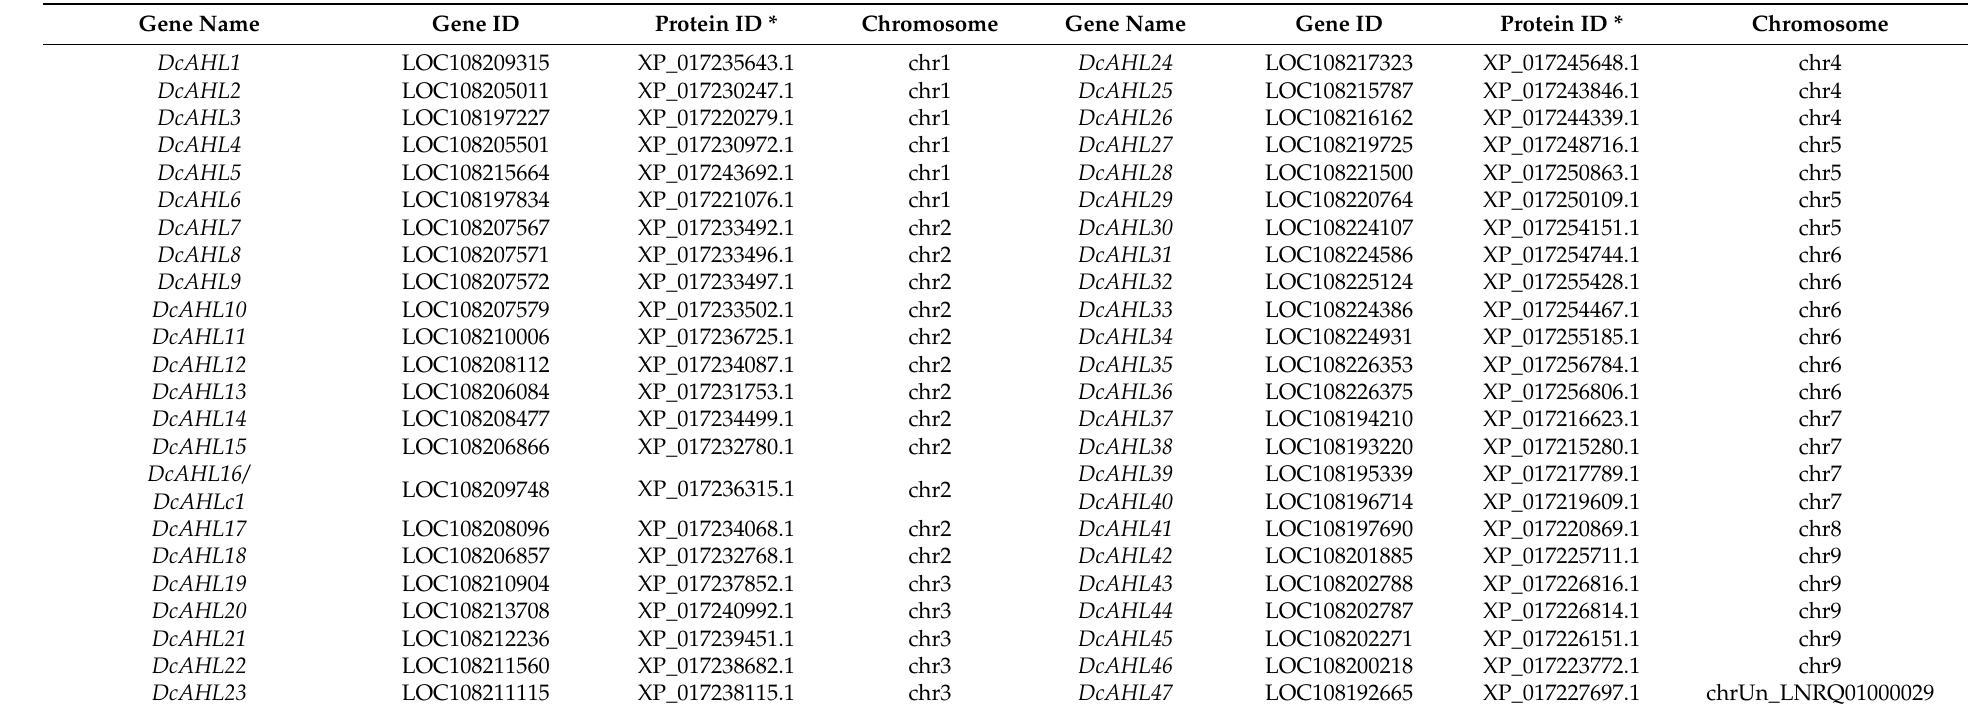
Table 1. List of AHL genes identified in